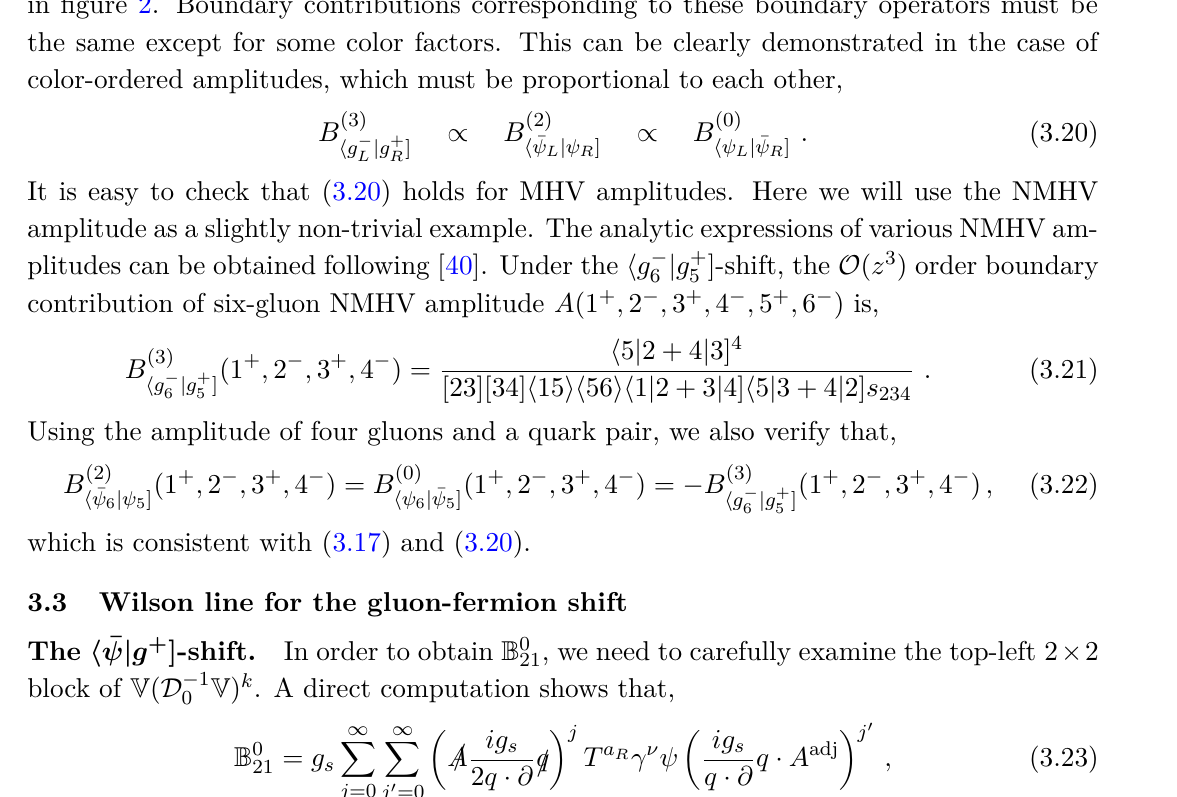
Figure 2 . At the leading g s order of boundary operators under h g − vertices are all represented by a operator emitting a gluon. Despite of color factors, three Feynman rules are the same, showing irrelevance to the actual shifted particles, represented by solid line for gluon and dashed line for